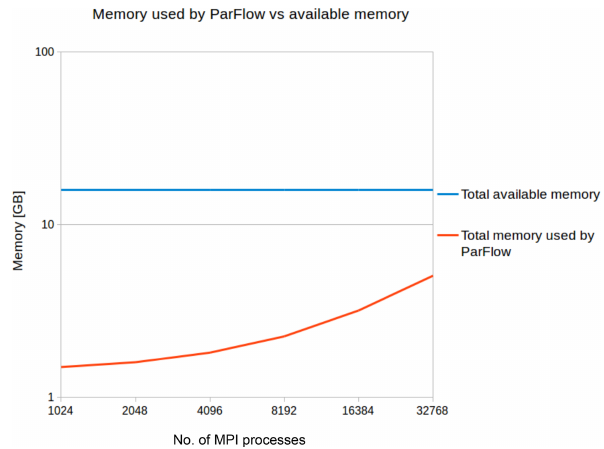
Figure 9. Memory usage of the weak scaling experiment described in Sect. 3.1 vs. the total amount of memory